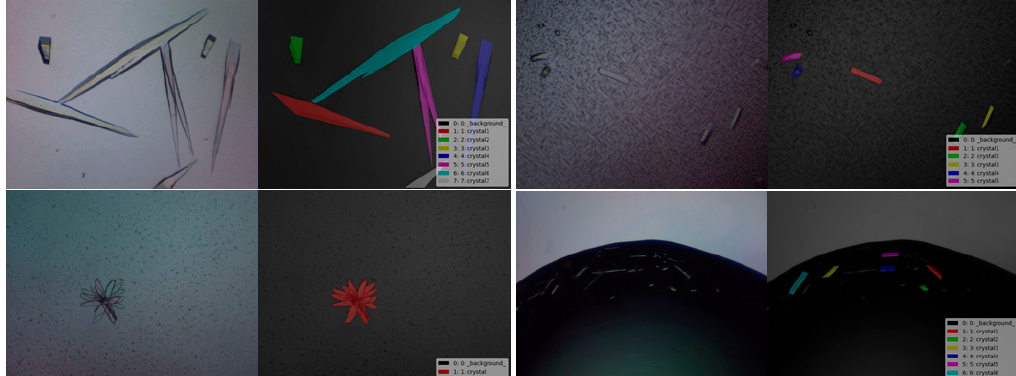
Figure 5. Four labeled mask images.